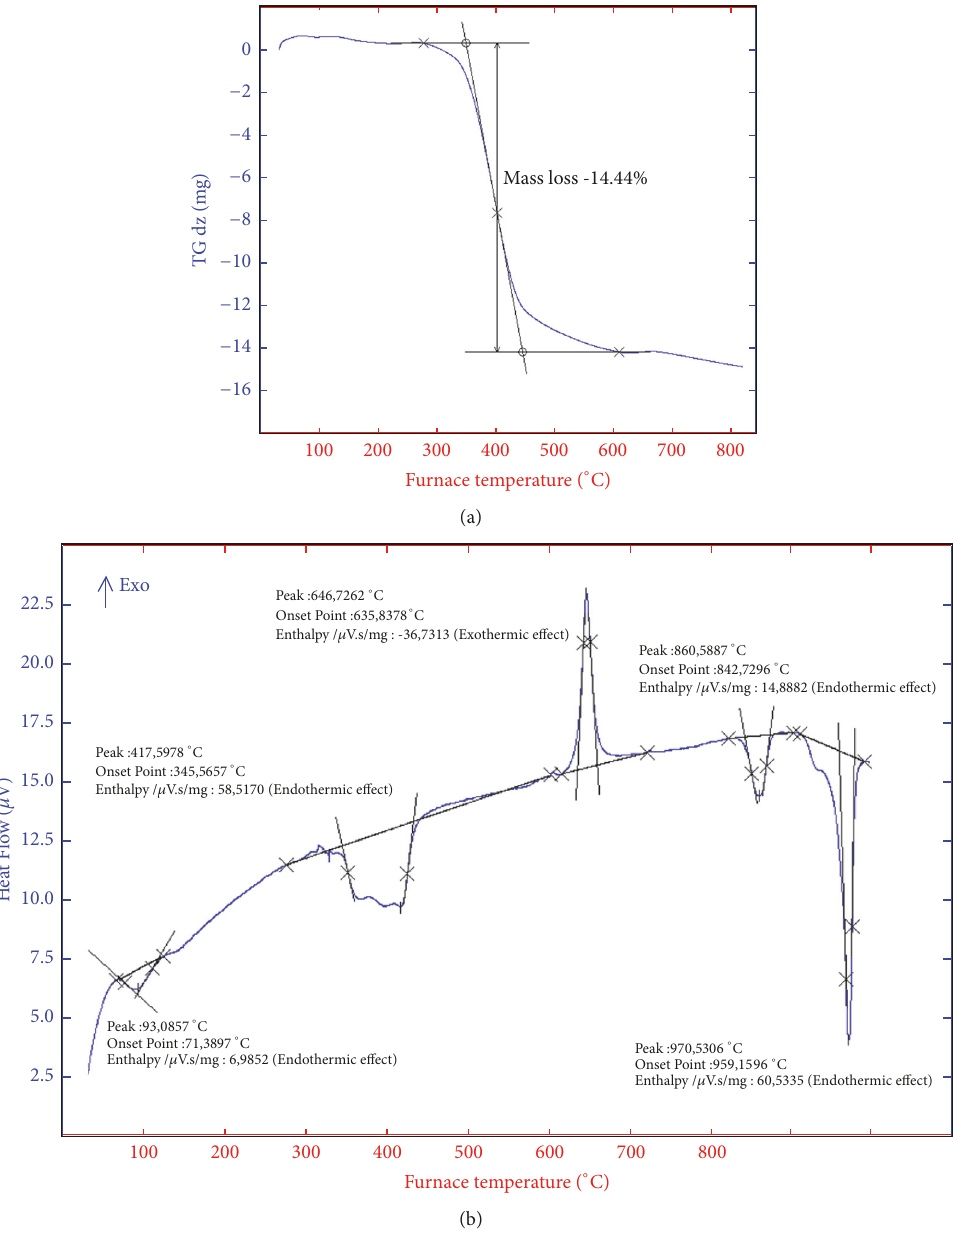
Figure 4: (a) TGA and (b) DTA curves of